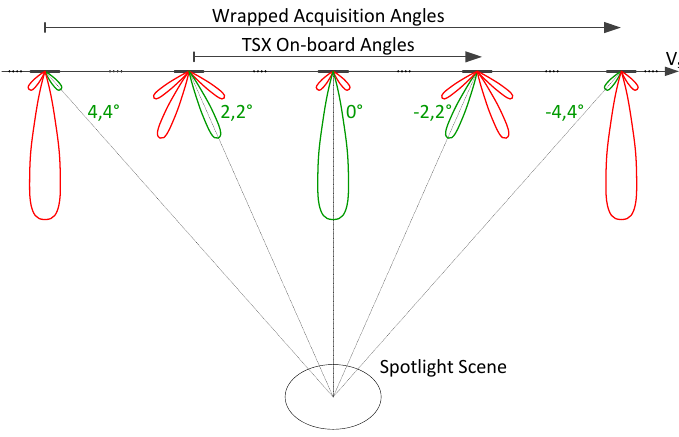
Figure 10. Desired steering lobes (green) and undesired grating lobes (red). TerraSAR-X on-board available angles up to ±2.2°. Steering angles beyond are obtained by re-accessing available steering angles.